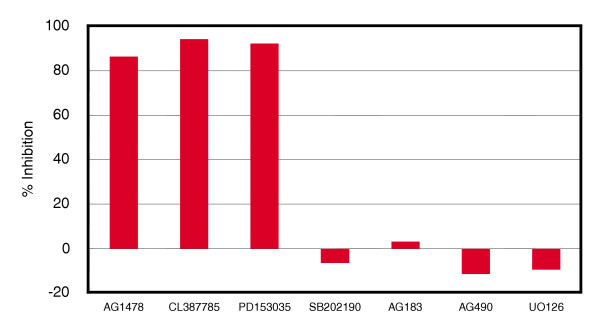
Biochemical assay results with kinase inhibitors. Percent inhibition values determined by using the Z'-LYTE technology platform (Invitrogen), and single point concentration testing (1 μM) with two independent data points (n = 2). Small molecule compounds CL387785, PD153035, and AG1478 show strong inhibition of the EGFR, while others tested exhibit none.